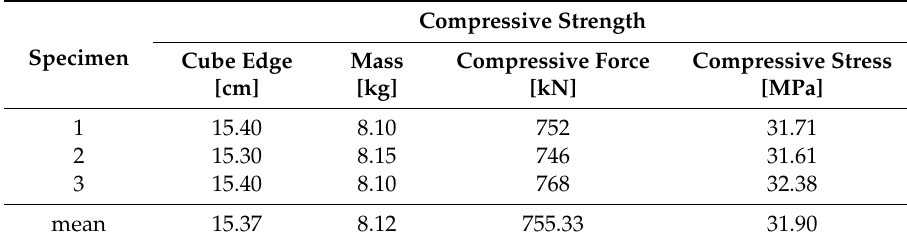
Table 4. The results of concrete compressive strength.